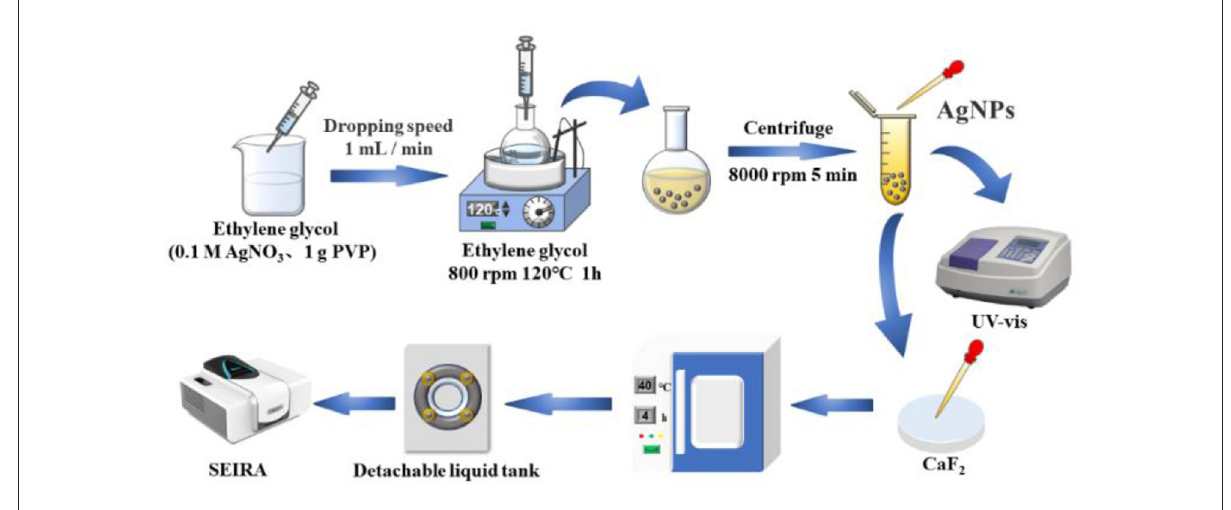
FIGURE1 Schematic diagram of silver nanoparticles based SEIRA